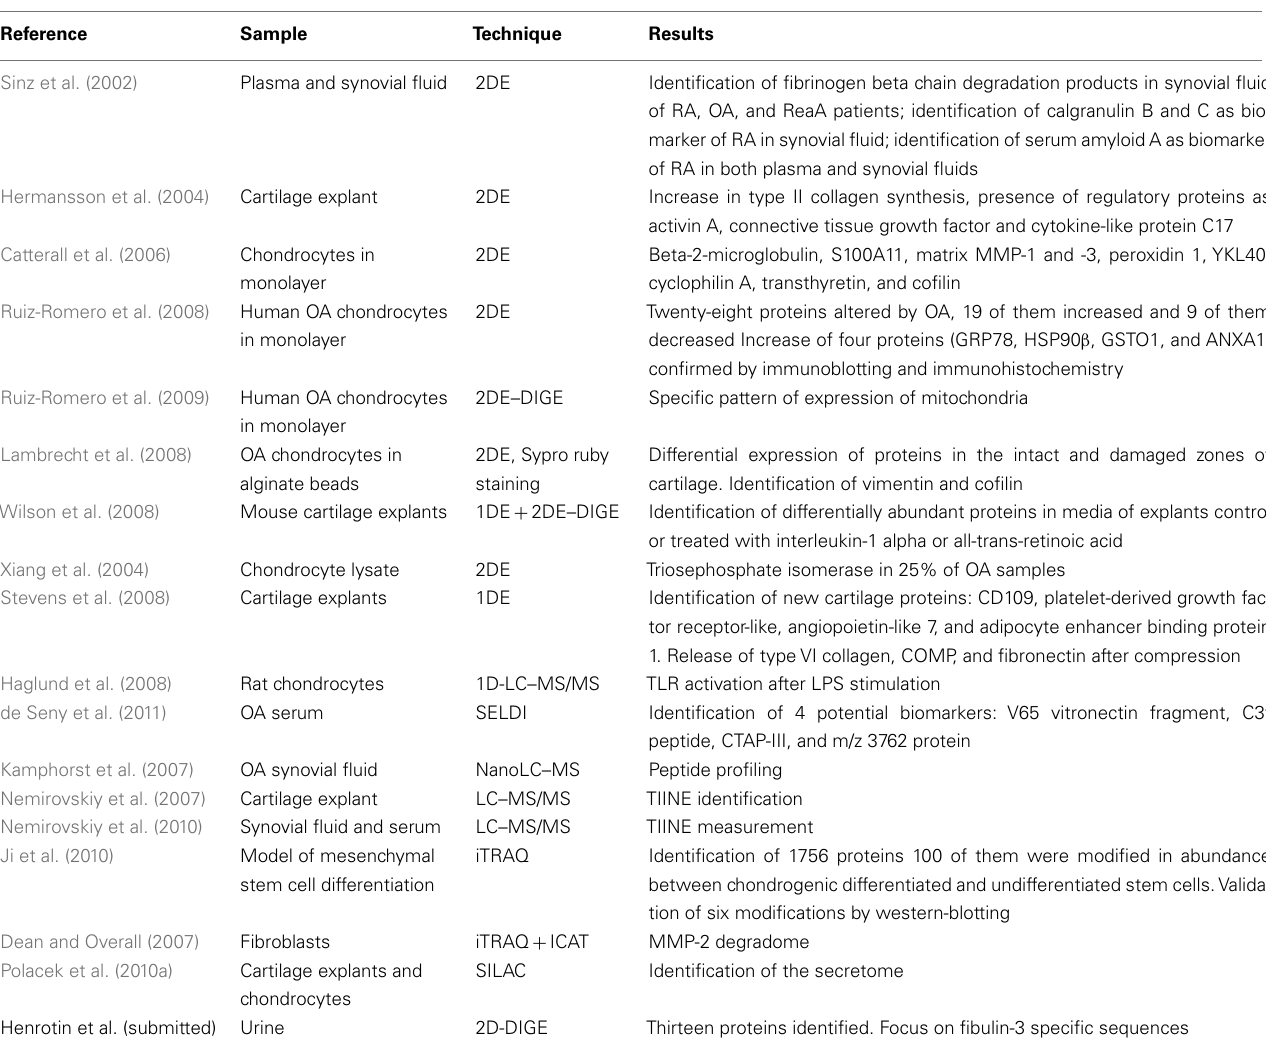
Table 1 | Identification of protein in OA samples with proteomic